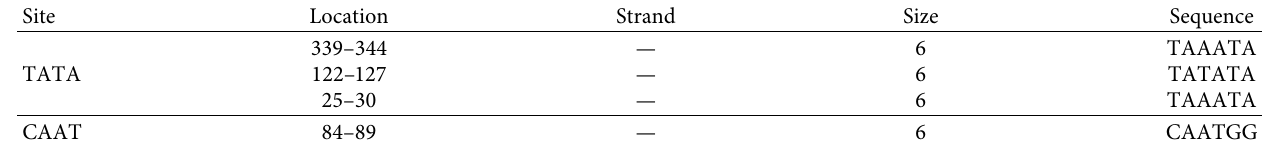
Table 1: Sites found in the TNP1 gene promoter region from the transcription start point. Site